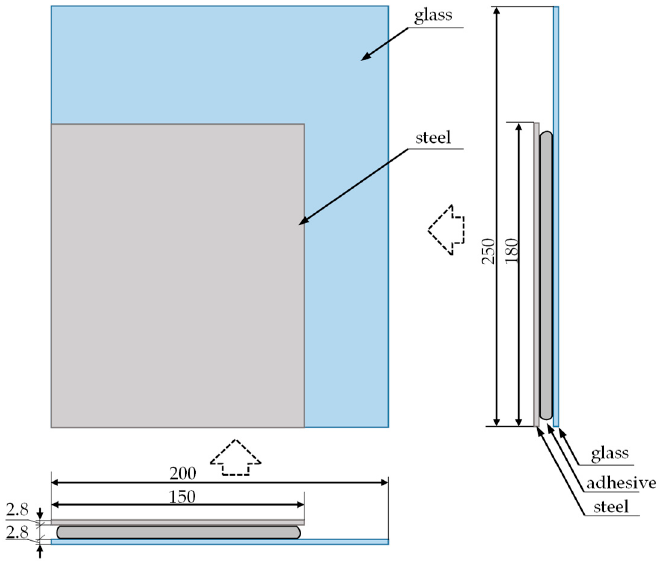
Figure 3. View of both surfaces of sample utilized during experiments: ( a ) view from the steel sheet side, ( b ) view from the side of the glass.